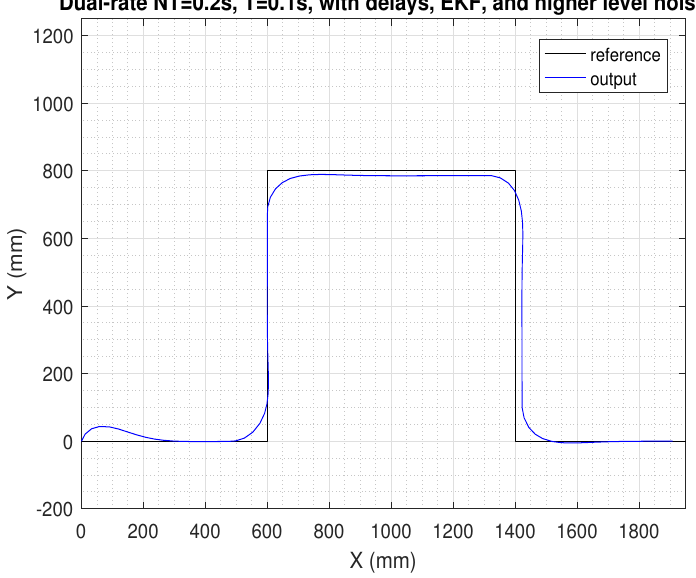
Figure 11. Results for the control proposal (EKF, prediction stage, and packet-based control) with delays and a higher level of